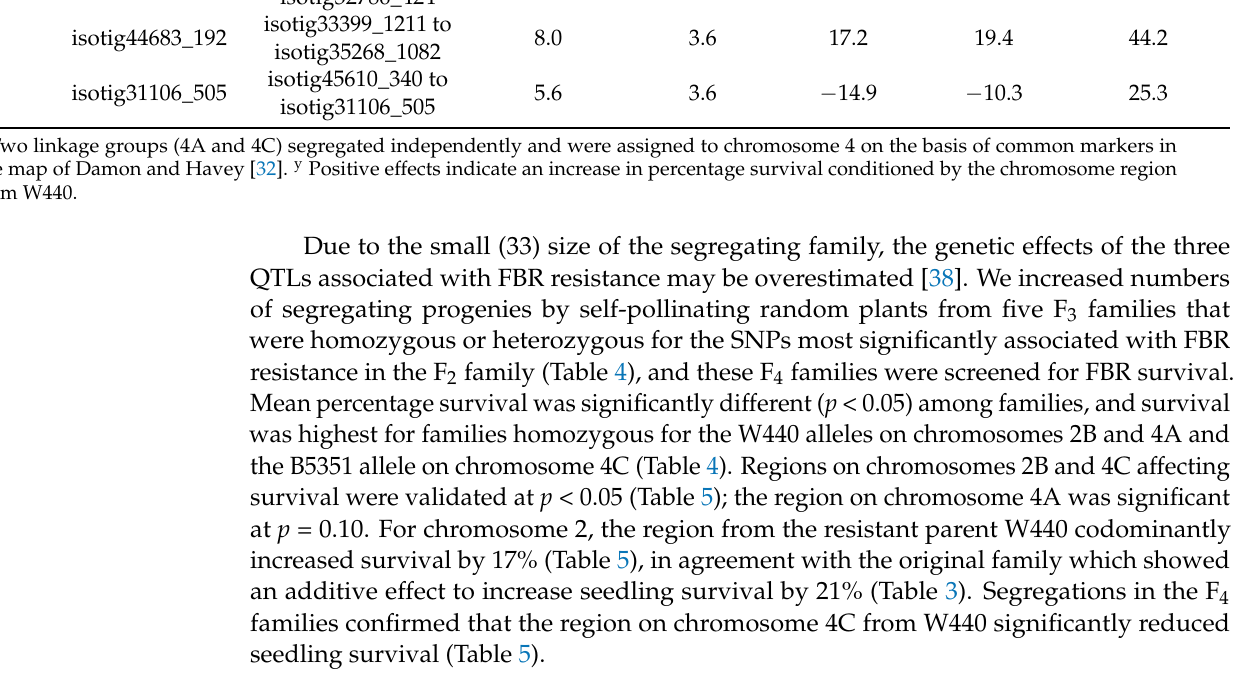
Table 3. Quantitative trait loci (QTLs) for resistance to Fusarium basal rot (FBR) in the segregating F 2 family of onion, single-nucleotide polymorphisms (SNPs) and 1.5 logarithm of odds (LOD) confidence interval associated with each QTL, LOD score and threshold, additive and dominance effects, and percentage (%) phenotypic variation explained by QTL.